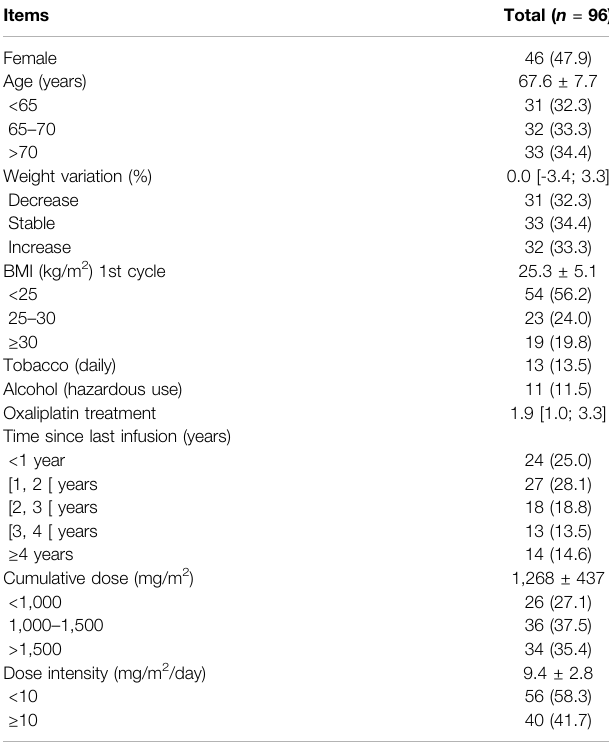
TABLE1| Characteristicsofthepatientsanalyzed.Dataarepresentedasnumber (percentages), mean ± standard deviation or median [interquartile